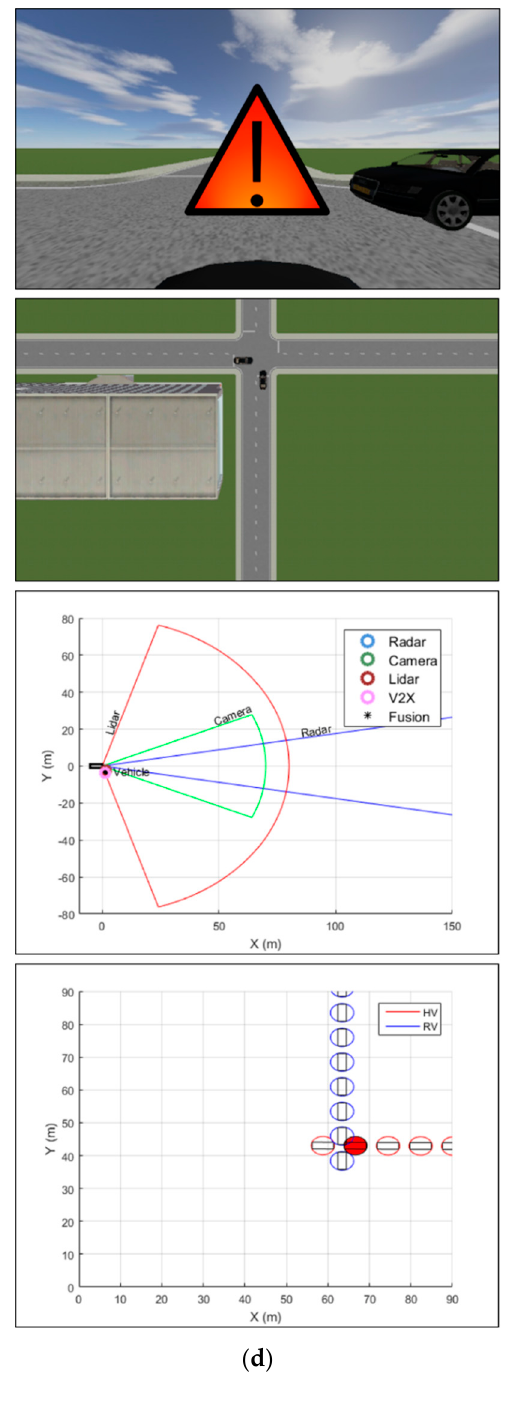
Figure 9. Vehicle–vehicle collision simulation results and snapshots of the experimental environment at different time points. Shown in the center of the forward-looking view image is the visual collision warning generated to the host vehicle. The bird’s-eye-view image of the road scene shows the locations of the vehicles at the corresponding time instance. The sensor fusion image shows the filtered measurements from various sensors as well as the fusion result. Trajectory prediction and risk assessment enable detection of potential collision location, which is represented by a circle colored in red. ( a ) Results for t = 1 s; ( b ) results for t = 2 s; ( c ) results for t = 3 s; ( d ) results for the time point just before the collision.